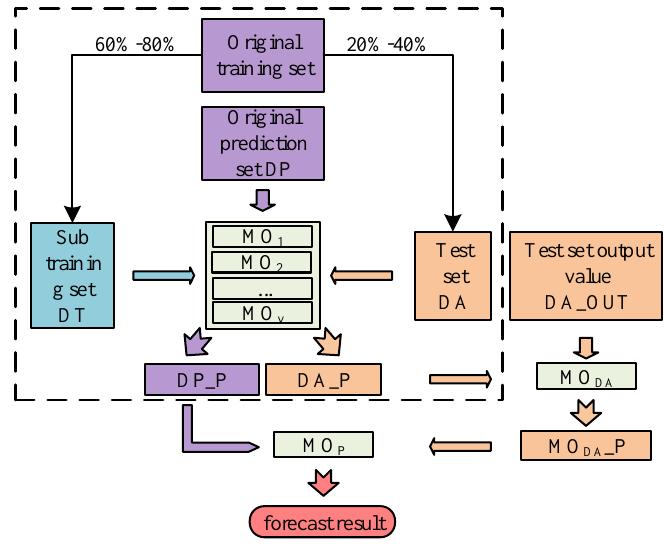
Figure 1. Schematic diagram of Blending fusion.